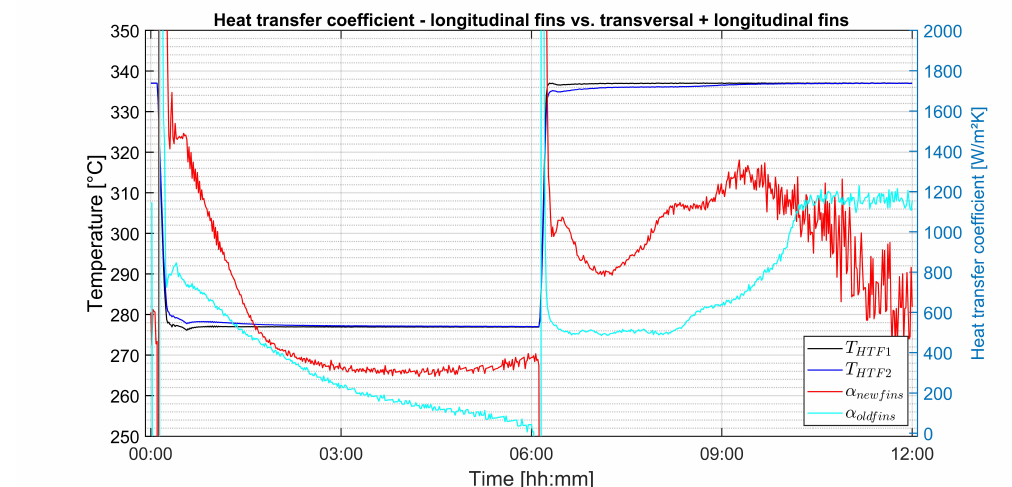
Figure 11. Apparent heat-transfer